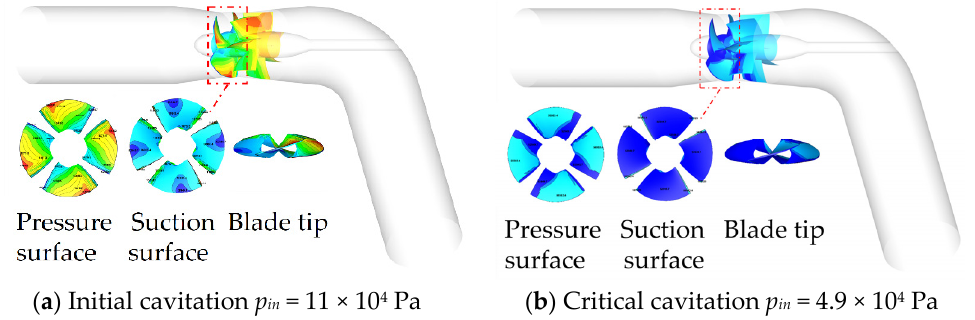
Figure 17. Flow condition Q = 380 L/s pressure distribution cloud diagrams.